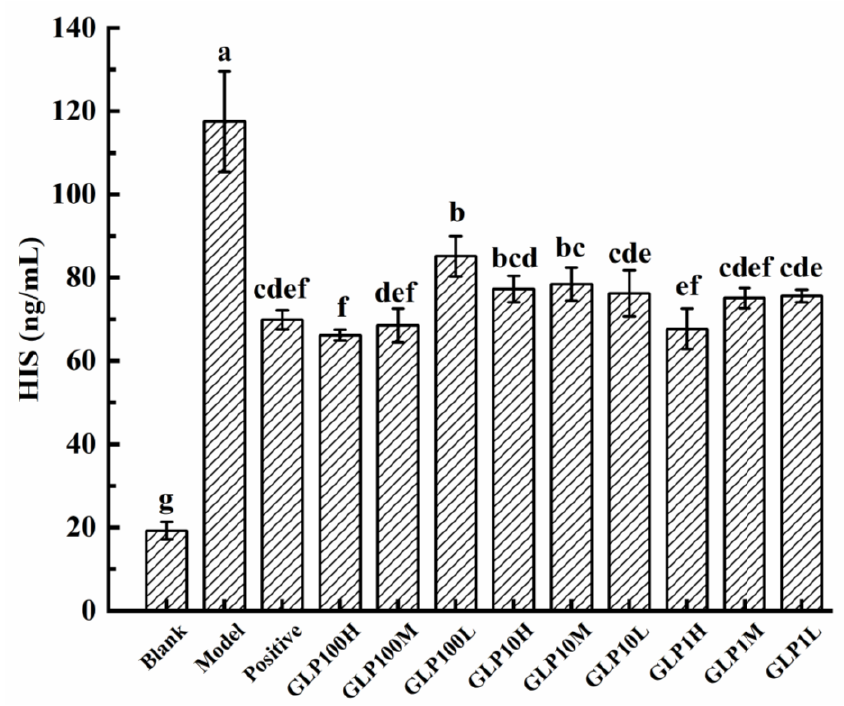
Figure 6. Effects of GLPs on HIS content in rats. Different lowercase letters (a – g) indicate significant differences at p < 0.05.